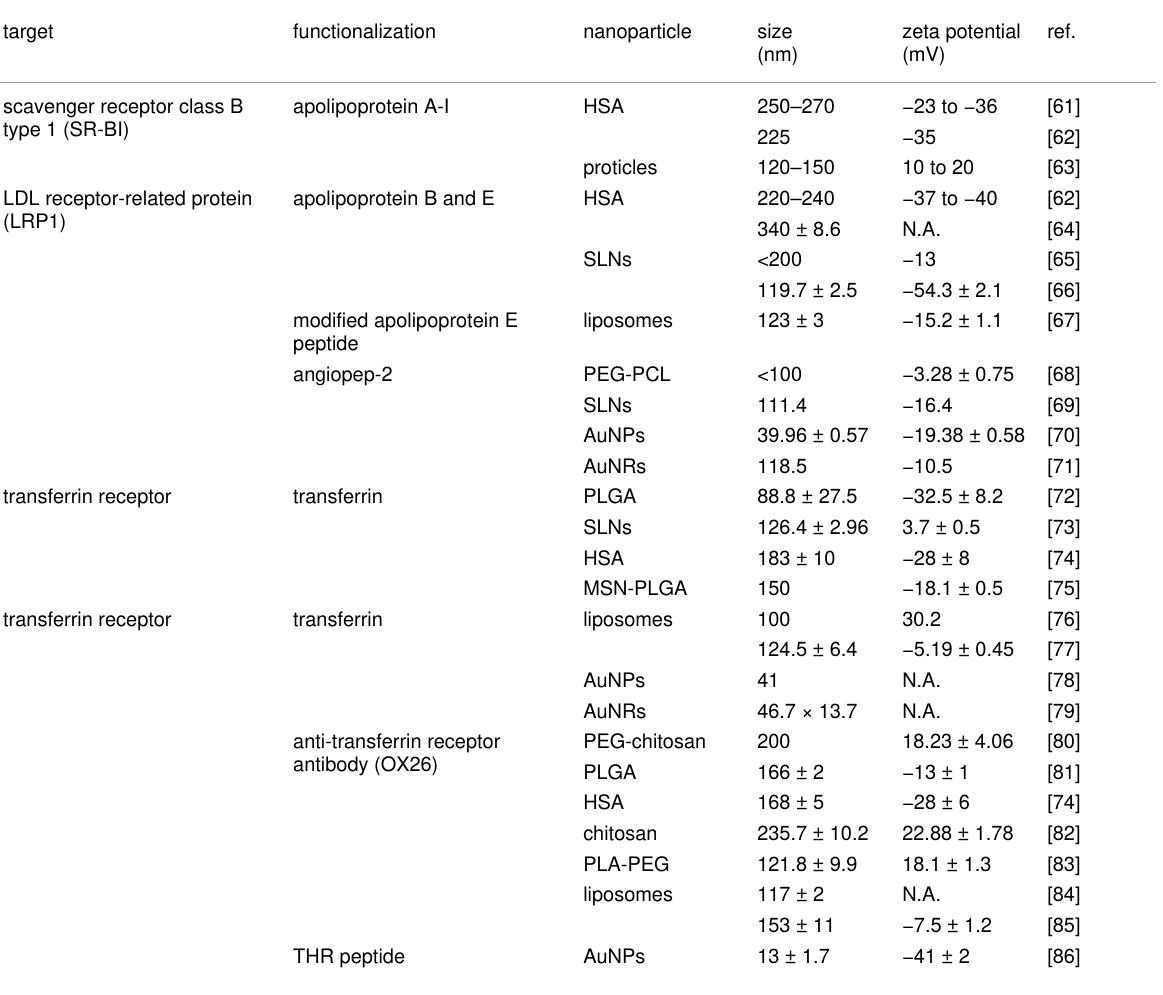
Table 1: Summary of surface functionalization strategies for improved BBB crossing of nanoparticles. a